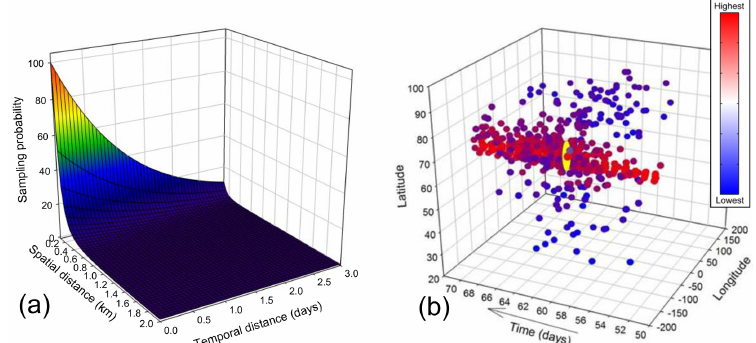
Figure 1. (a) Sampling probability as a decreasing function of spatial and temporal distance as used in this study. (b) The typical example of subsampled IASI Level 2 XCH 4 (altitude below 4km) data for a selected estimation location (yellow circle). The colors of the observations show semivariance between observation and estimation locations (blue: lowest; red: highest). Due to stronger temporal covariance, the relative decrease in the sampling probability along the temporal axis is smaller than with spatial